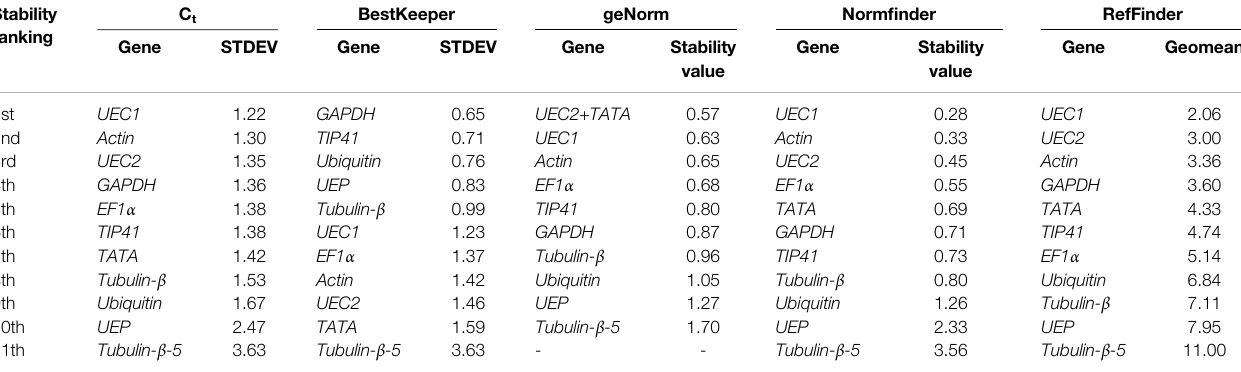
TABLE 5 | Stability ranking of 11 candidate reference genes with tissues (matured leaf and stem) and under drought conditions (matured leaf) from young R. delavayi . Stability ranking